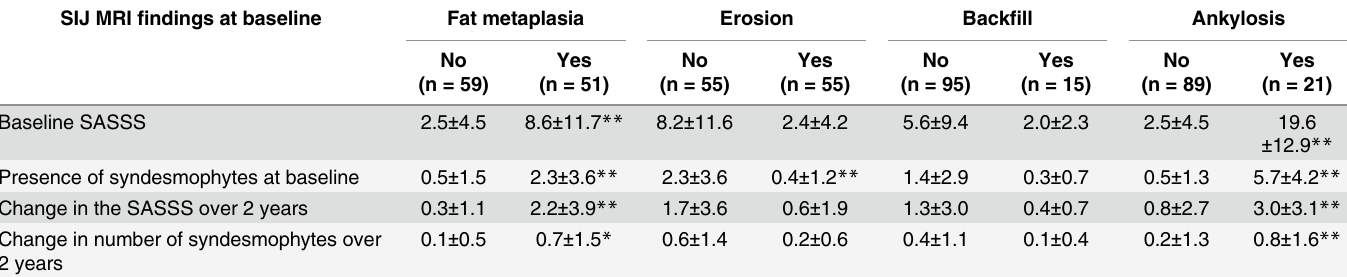
Change in number of syndesmophytes over 2 years